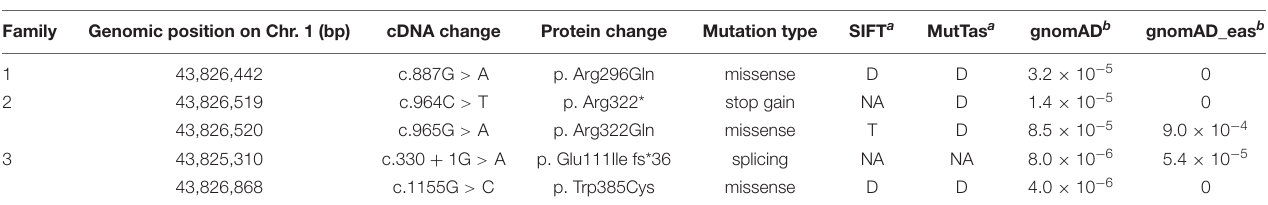
TABLE 2 | Overview of the CDC20 mutations observed in the three families. Family Genomic position on Chr. 1